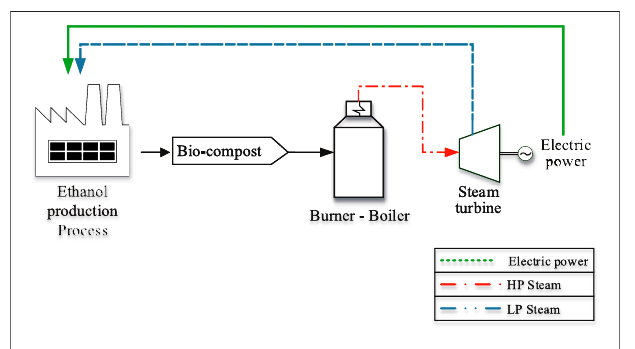
FIGURE 1 | Combined heat and power (CHP) schematic